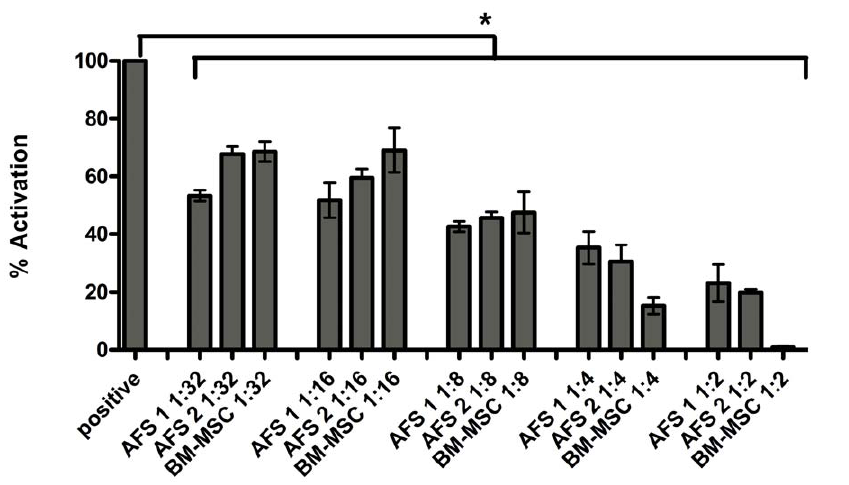
Figure 2. Human AFS cells inhibit lymphocyte activation in a dose dependent manner similar to that of BM-MSCs. Immunoassays assessing lymphocyte activation were performed on two independent amniotic fluid stem cell lines (AFS1 and AFS2) or bone marrow-mesenchymal stem cell (BM-MSC) isolates. T lymphocytes were activated with phytohemaaglutinin (PHA) and cultured in 96 well plates coated with IFN- c capture antibody in the presence of increasing amounts of stem cells from 1:32 (4,688 stem cells cultured with 150,000 PBMCs) to 1:2 (75,000 stem cells cultured with 150,000 PBMCs) for 24 hours. Positive control wells contained lymphocytes activated with PHA and negative control wells included unactivated lymphocytes. Lymphocyte activation was assessed by counting the number of lymphocyte clones producing IFN- c . Activation is expressed as a percentage of the positive control wells. Both AFS lines and BM-MSC inhibited T-cell compared to the PHA activated control to an approximately equal extent, and was dependant on the number of stem cells added. Inhibition varied from about 40% at a 1:32 ratio to 80–90% inhibition at the highest ratio of 1:2.